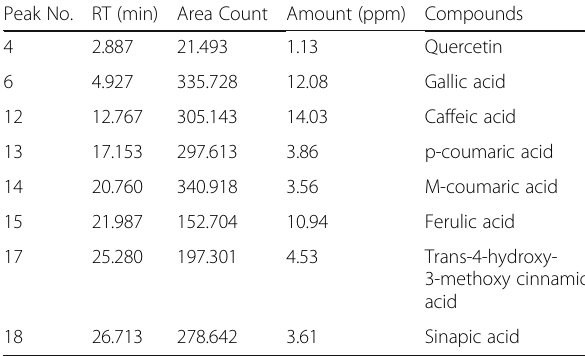
Table 7 Phenolic constituents identified in n -butanol fraction of